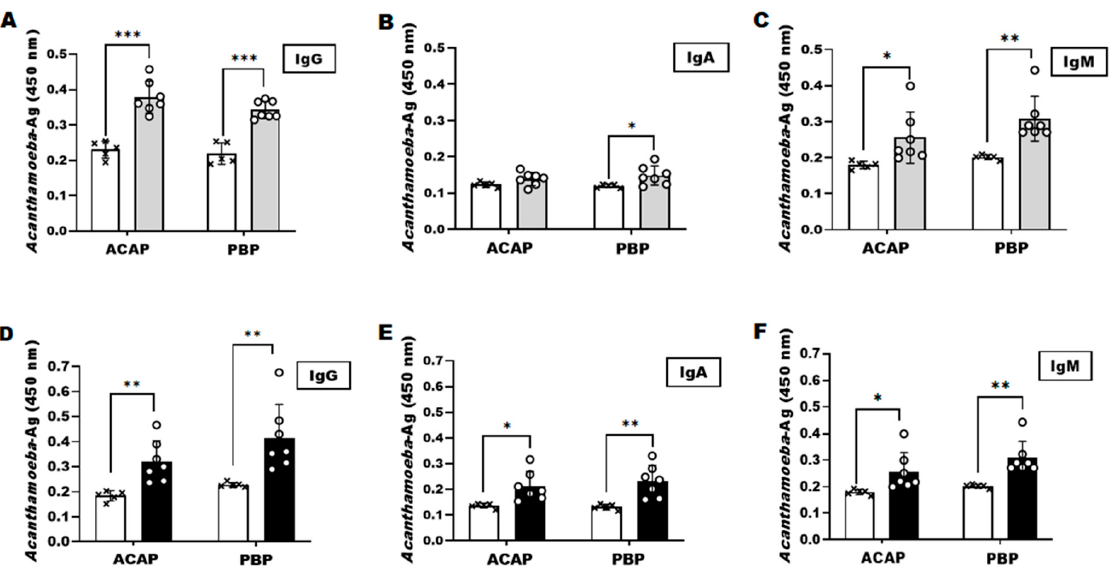
Figure 4. Detection of Acanthamoeba antigens in eyeball lysates. The eyeballs of the AK mouse model were collected after 7 ( A – C ) and 21 ( D – F ) dpi with A. castellanii . The eyeballs were sonicated in PBS and used for detection of the Acanthamoeba antigens by ACAP and PBP antibodies. IgG, IgA, and IgM antibody subtypes were used to determine the antigen-antibody responses. Negative ( × ); naïve eyeball lysates, positive ( ○ ); AK-mouse eyeball lysates. Data are expressed as mean ± SD and asterisks denote statistical significance between the means of the two groups (* p < 0.05, ** p < 0.01, and *** p < 0.001).